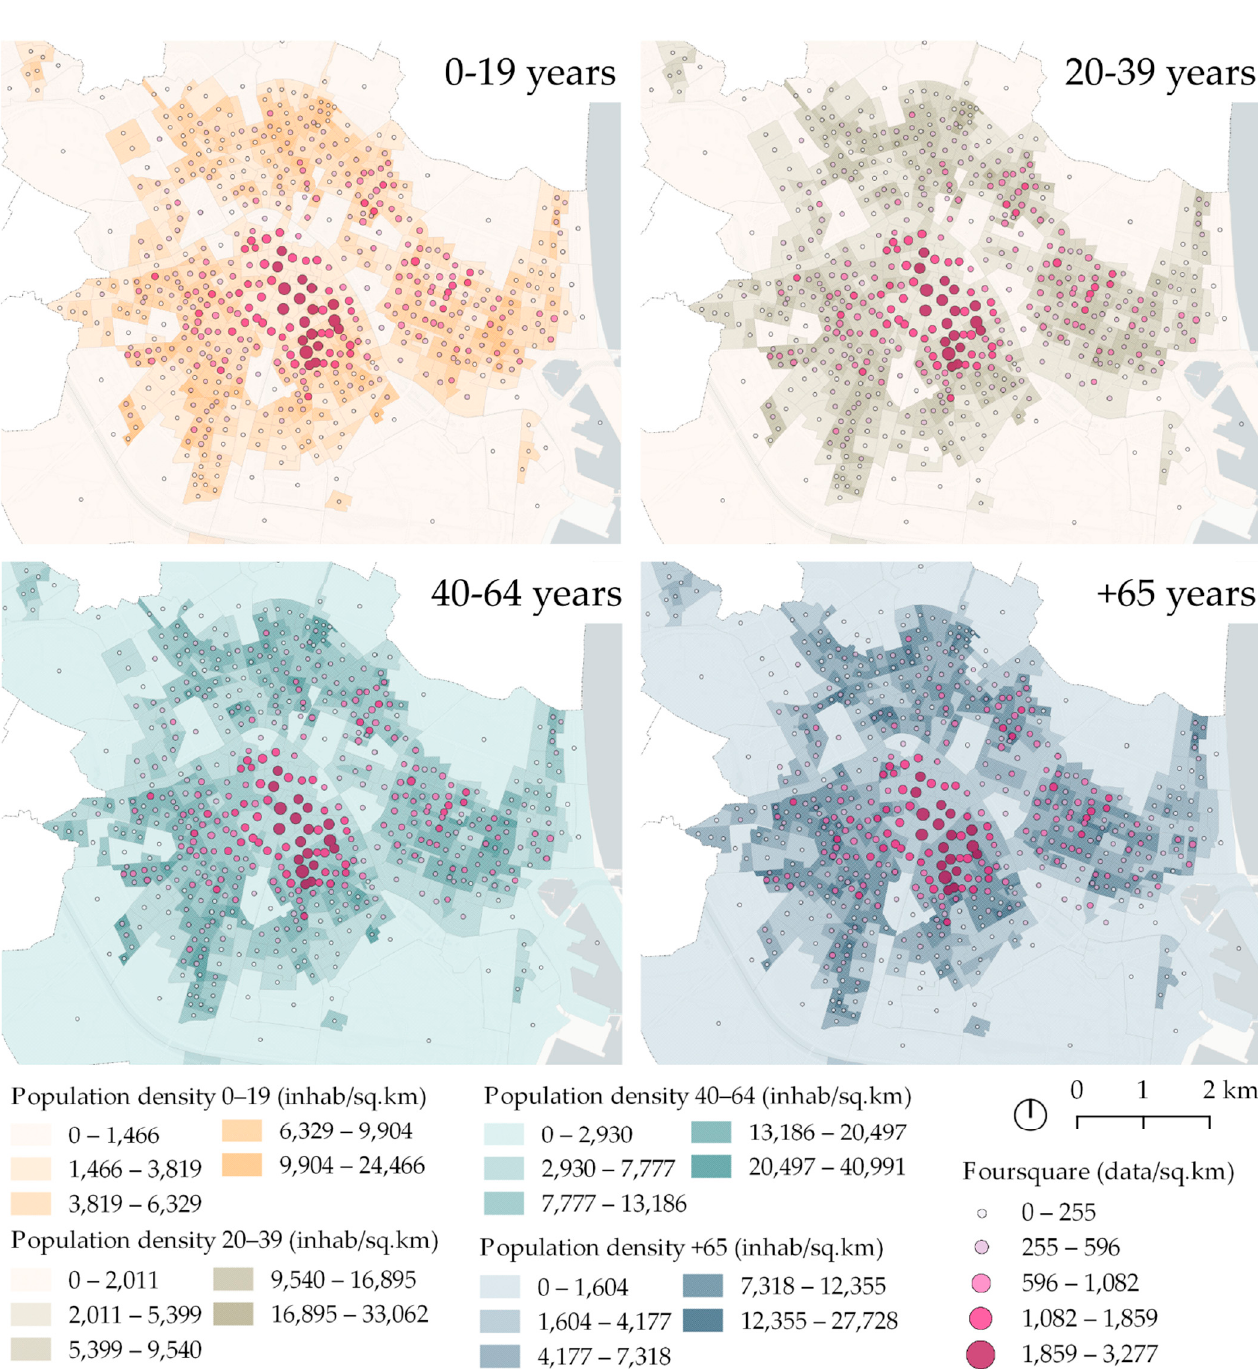
Figure 6. Population density per age group and Foursquare data density.